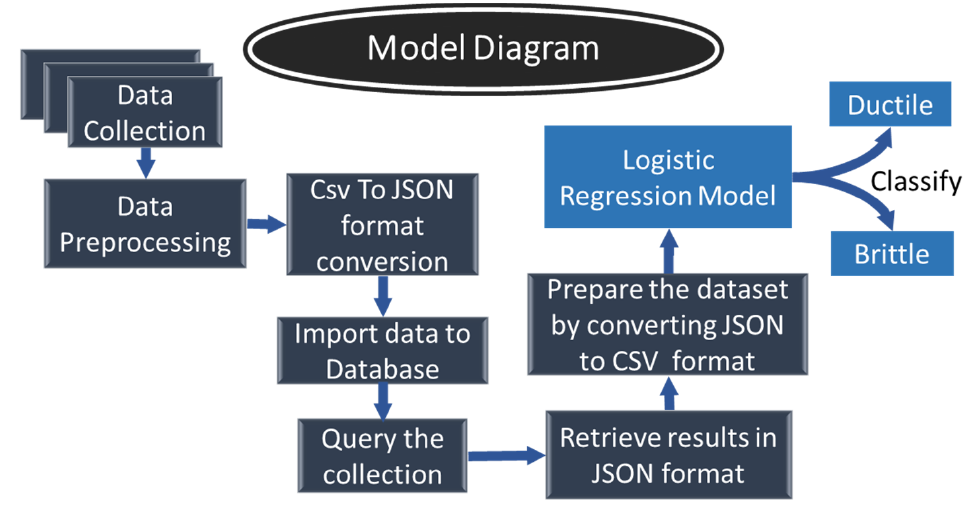
Figure 1. Model Diagram for the classification of Material Science data.